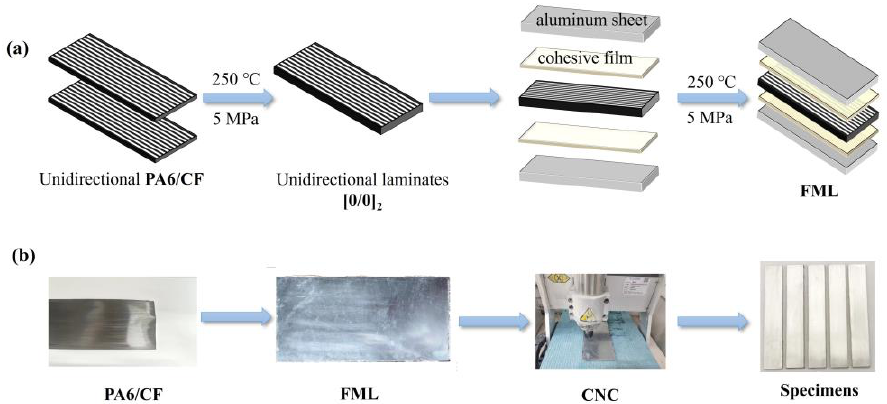
Figure 1. The manufacturing process of thermoplastic fiber metal hybrid laminates